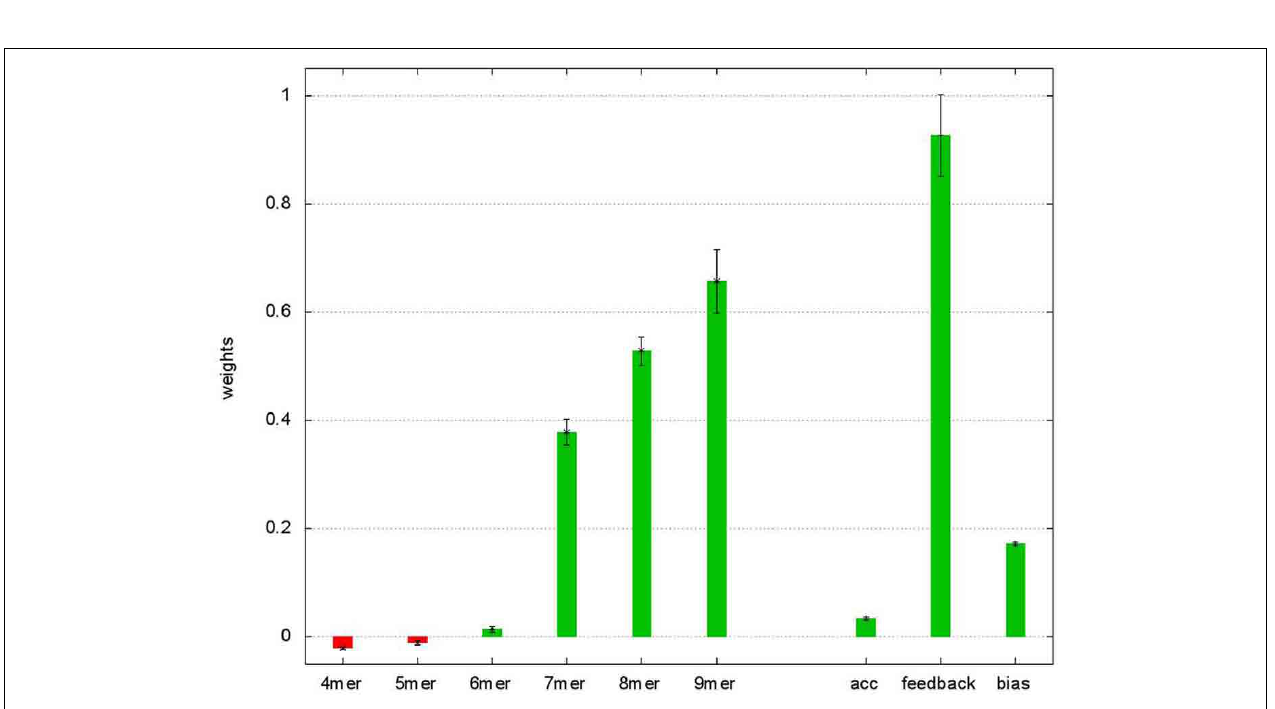
conservation of the corresponding seed match size. “acc” Denotes the weight to the structural accessibility feature, “feedback” is the weight on the feedback connection and “bias” the bias term in Eq.